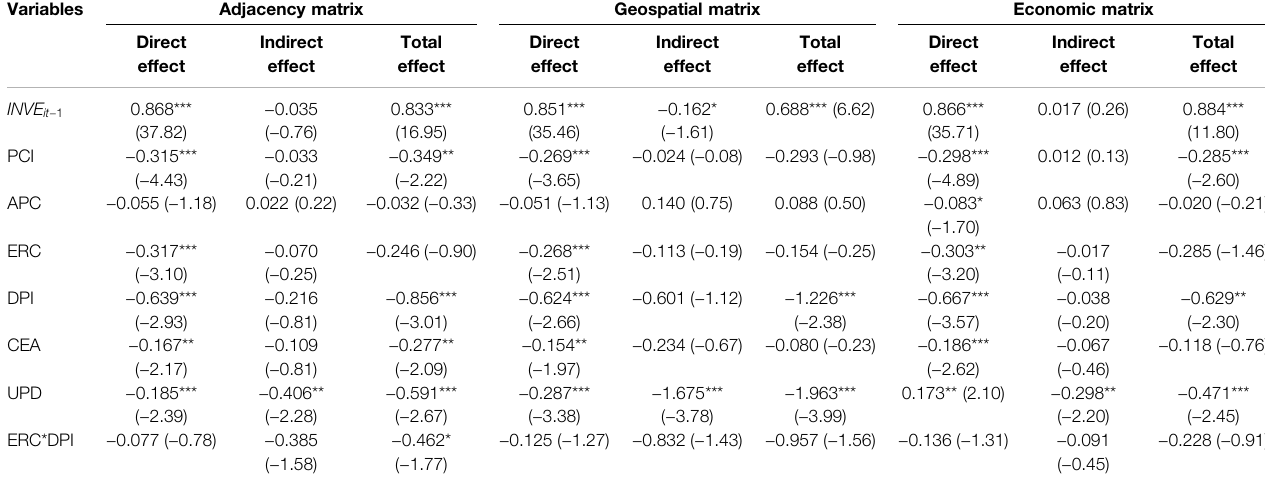
TABLE 8 | Decomposition of the random effects SDM